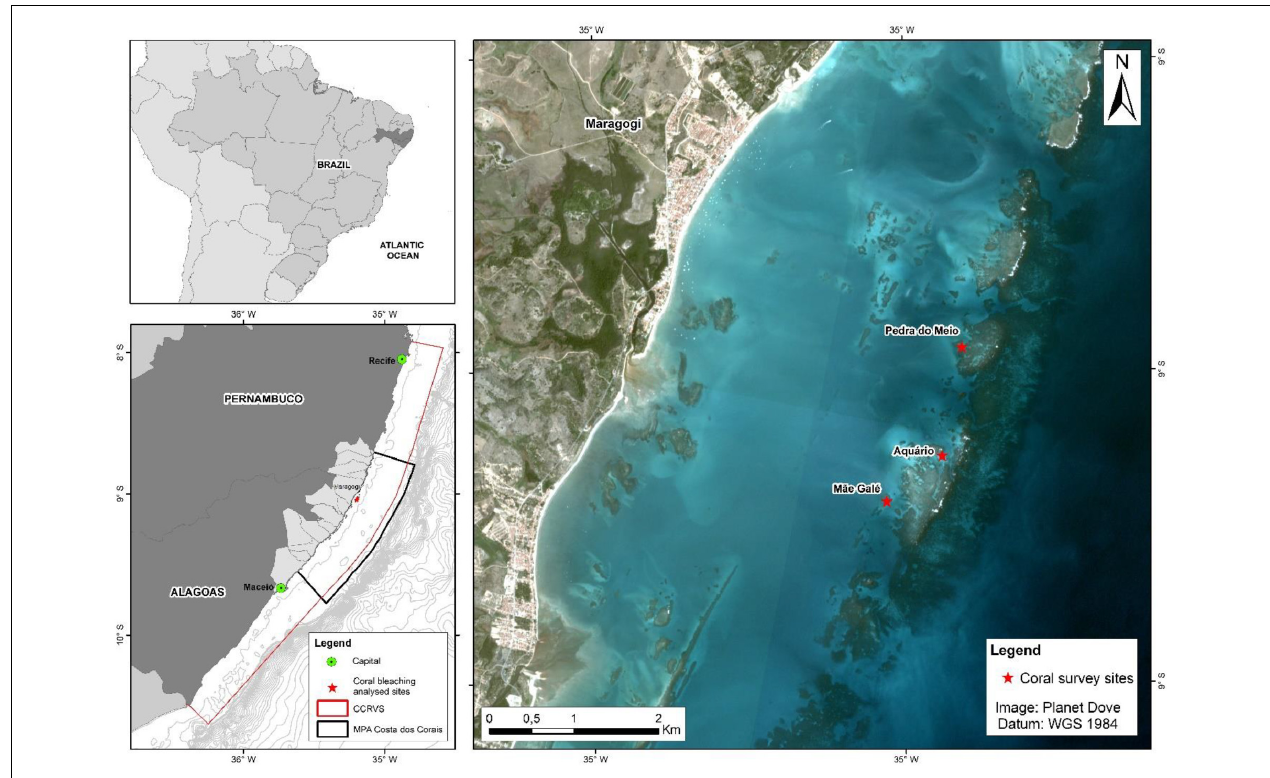
FIGURE 1 | Study area for monitoring bleaching, highlighting sampling sites (red stars in the right hand map) at marine protected area (MPA) Costa dos Corais (APACC, black line in lower left map) and NOAA’s Coral Reef Watch greater Costa dos Corais Regional Virtual Station (CCRVS, red line in lower left map). The red star on the bottom left map marks the coastal center of the degree heating week (DHW)